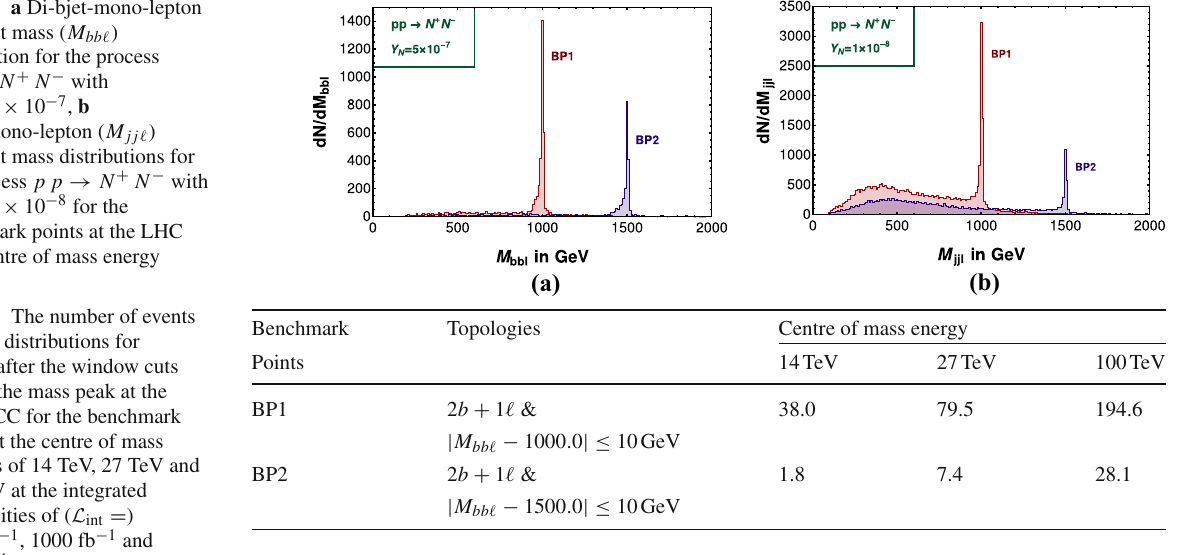
Fig. 15 a Di-bjet-mono-lepton